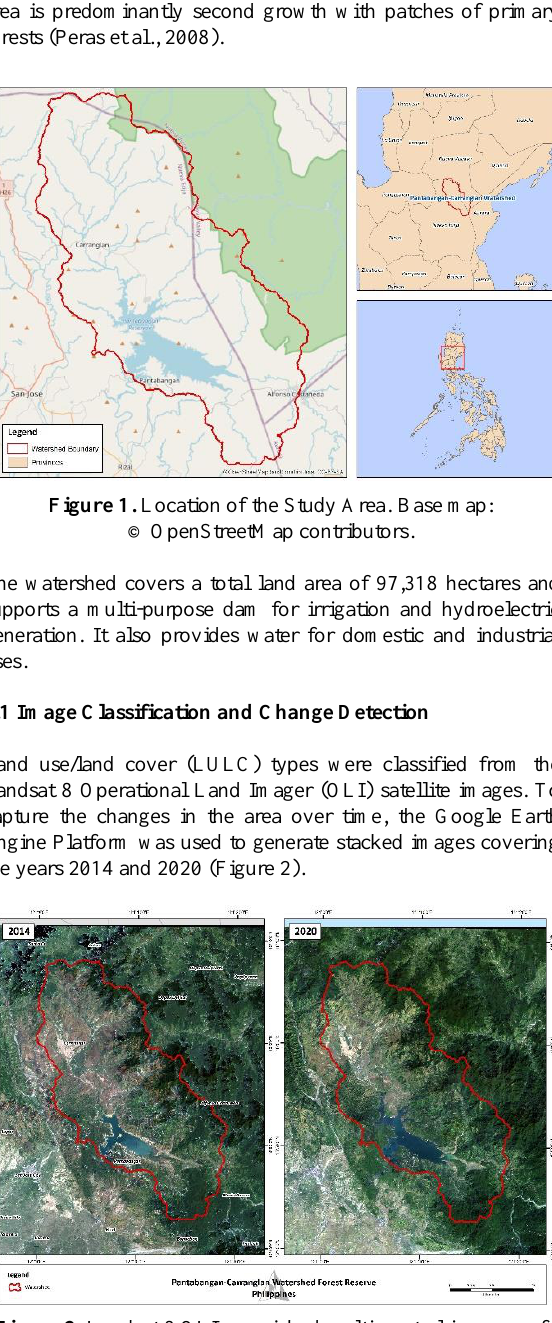
Figure 2 . Landsat 8 OLI mosaicked multispectral imagery of Pantabangan-Carranglan Watershed for 2014 and